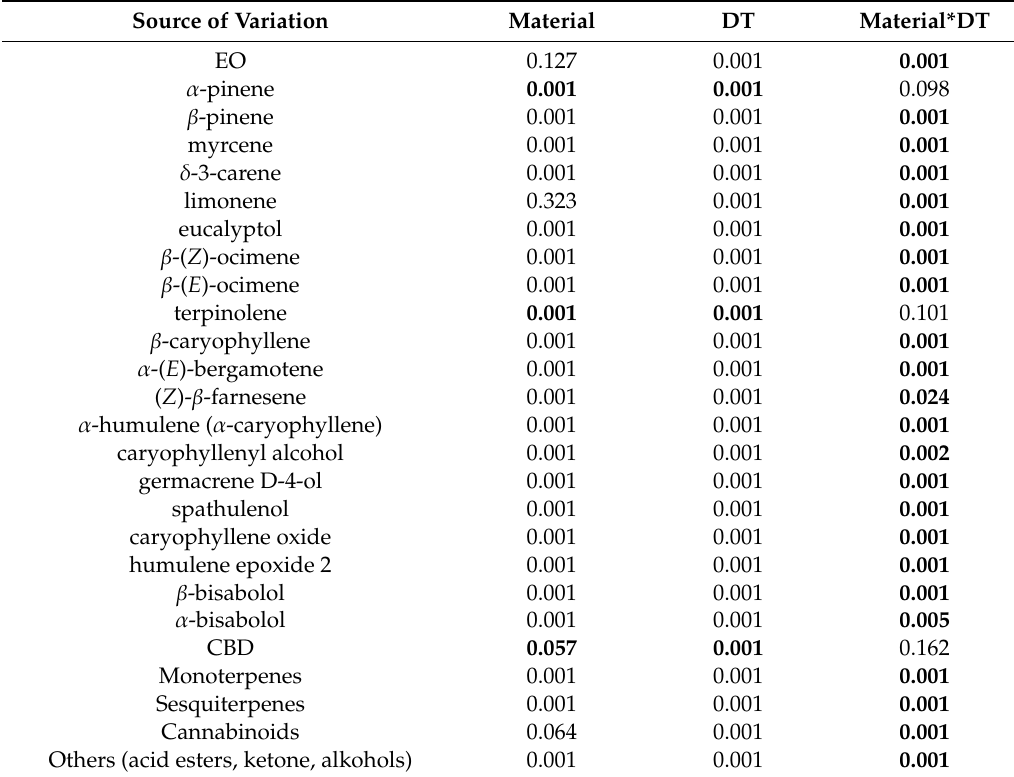
Table 1. ANOVA p -values ( p ) that show the significance of the main and interaction e ff ects of Material and Distillation Time (DT) on 26 response variables. P -values of significant e ff ects that require multiple means comparison are shown in